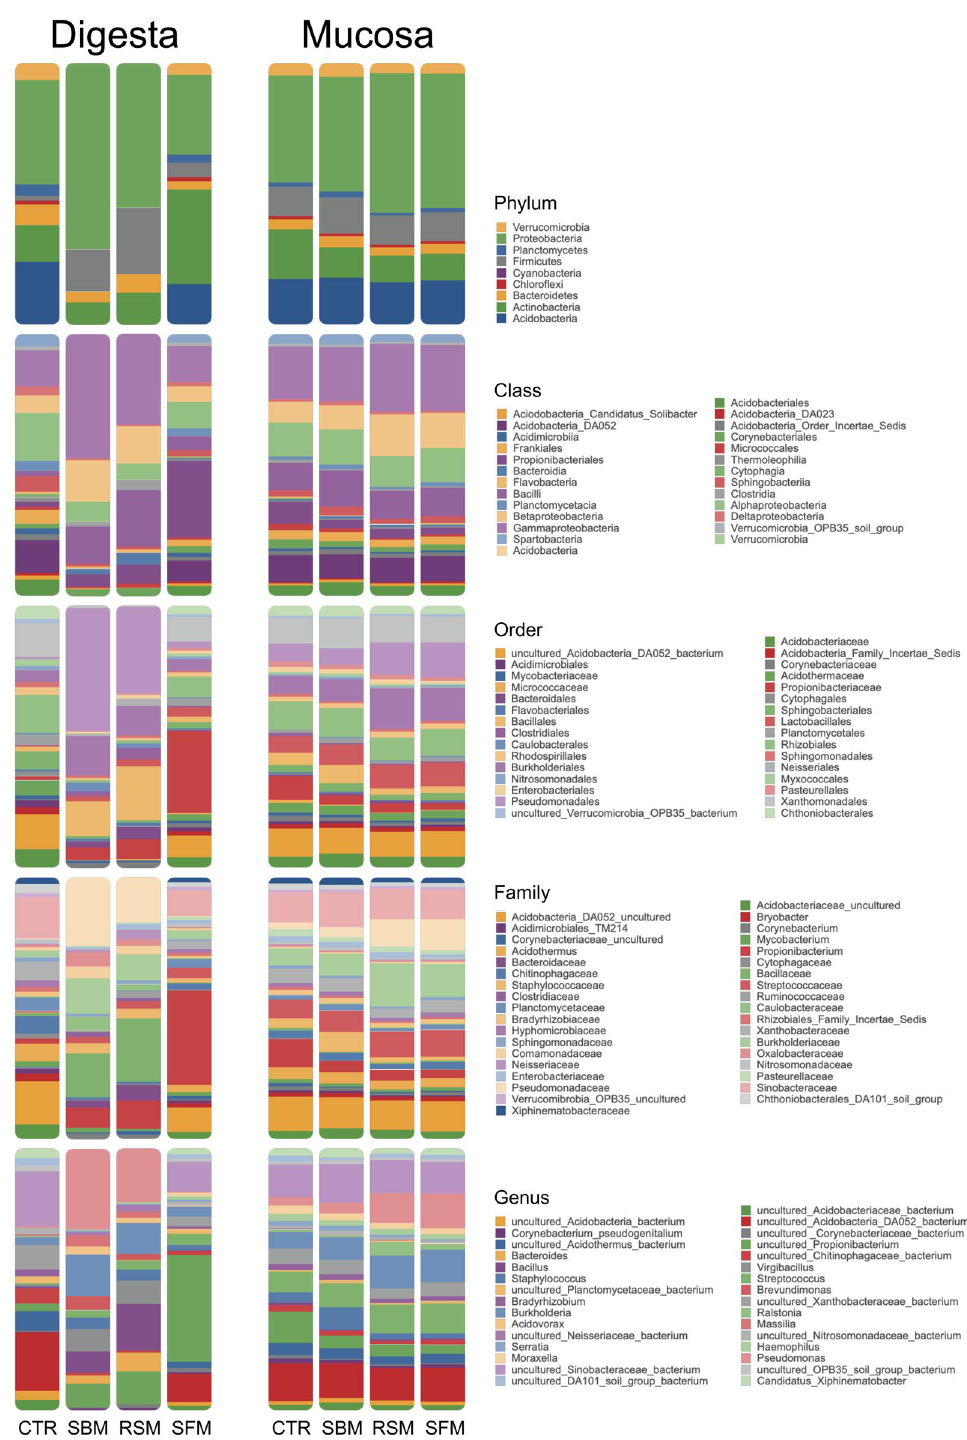
Figure 2. Relative bacterial abundance ( y -axis) at Phylum, Class, Order, Family and Genus Taxonomic levels (from top to bottom), in Digesta and Mucosa samples of European sea bass feed the experimental diets for 45 days ( x -axis): CTR, control fishmeal based diet; SBM, soybean meal based diet; RSM, rapeseed meal based diet; SFM, sunflower meal based diet. Presented are taxa with a mean proportion ≥ 1% in any experimental feeding